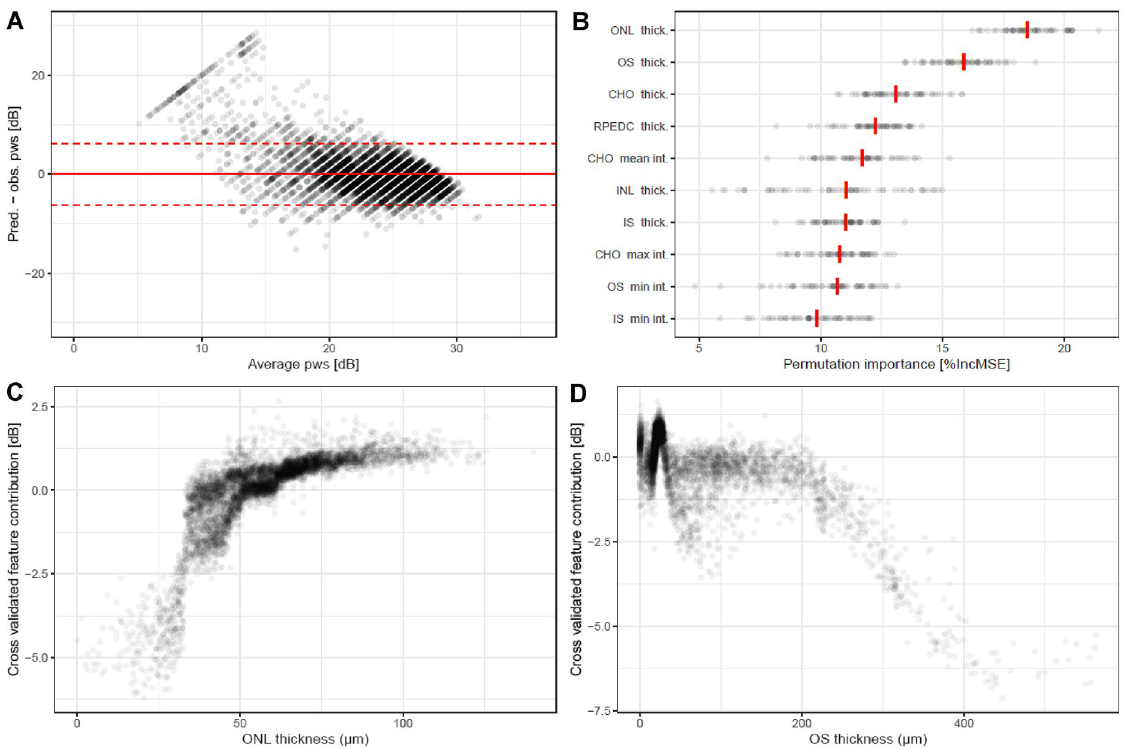
Figure 1. Accuracy of retinal sensitivity predictions for an “unknown patient”. (A) Shows a Bland–Altman plot for the point-wise differences between estimated and observed retinal sensitivity. The red solid line shows the mean difference, the red dashed lines the 95% limits of agreement. (B) Shows the feature importance in terms of the percentage increase in mean squared error (%IncMSE) for the 10 most relevant features. Each dot denotes the feature importance estimate for a given iteration of the outer cross-validation. Of note, across all iterations of the outer cross-validation, the outer nuclear layer thickness and photoreceptor outer segment thickness constituted the most important imaging feature. The red vertical lines indicate the median feature importance across folds. As shown in the feature contribution plots in (C,D) , an outer nuclear layer thickness of 40 µm or less was associated with a marked reduction in retinal sensitivity. Photoreceptor outer segment thickness exhibits a more complex relationship with retinal sensitivity. Outer segment thinning was associated with a reduction in retinal sensitivity, as well as outer segment thickening, which mostly represents subretinal fluid based on the here applied layer definitions. Abbreviations: prediction (pred.), observation (obs.), point-wise retinal sensitivity (pws), thickness (thick.), intensity (int.). Retinal layer: inner nuclear layer (INL), outer nuclear layer (ONL), outer segments (OS), inner segments (IS), retinal pigment epithelium-drusen complex (RPEDC), choroid